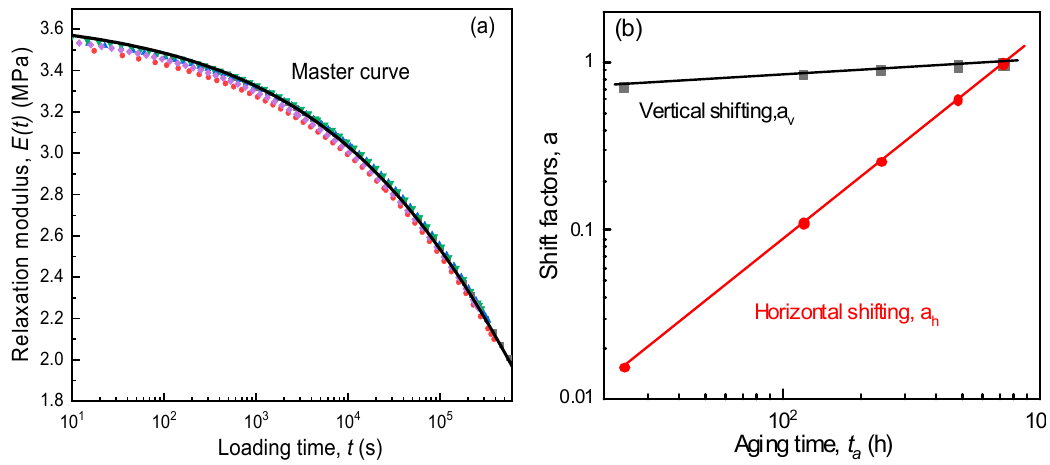
Figure 6. Relaxation master curve ( a ) and shift factors ( b ) for SPE films.